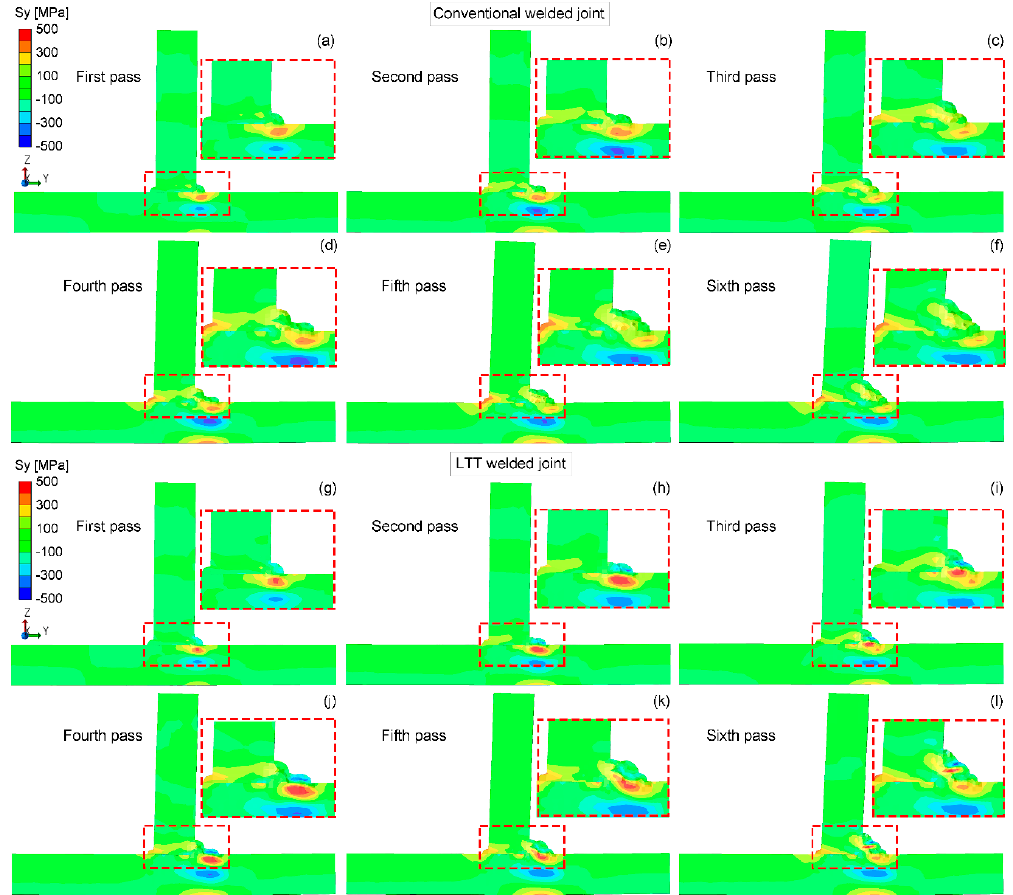
Figure 9. Residual Sy stress distribution in the mid-section of the conventional and LTT welded joints: ( a ) & ( g ) first pass; ( b ) & ( h ) second pass; ( c ) & ( i ) third pass; ( d ) & ( j ) fourth pass; ( e ) & ( k ) fifth pass; ( f ) & ( l ) sixth pass.